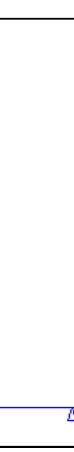
Figure 3. Chromatogram of the (+)-dihydrocarvone mixture of two diasteoisomers: trans (1 R , 4 R )-(+)-dihydrocarvone ( 2 ) with R f = 7.114 and cis (1 S , 4 R )-(+)-dihydrocarvone ( 3 ) with R f = 7.363.